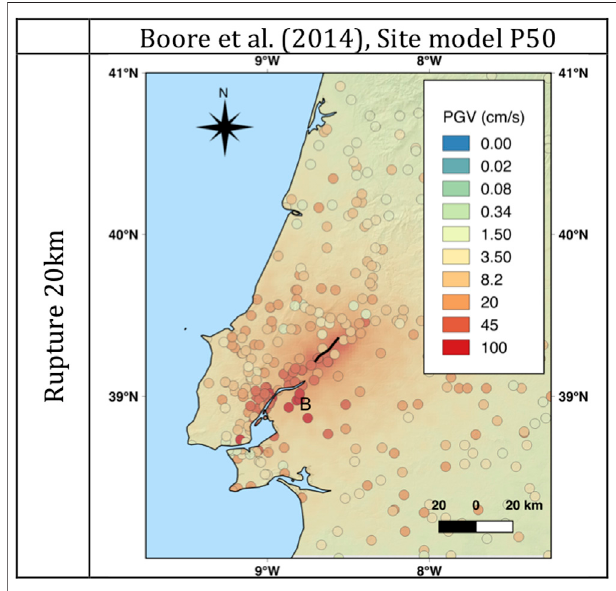
FIGURE 13 | PGV Scenario calculation for a 20 km rupture (Mw6.4) including the trench site (located at the northernmost part of the rupture) and macroseismic intensity dataset for the 1909 according to Teves-Costa and Batlló (2011) converted to PGV through the Caprio et al. (2015) relationship for Italy. The location of Benavente (B) is